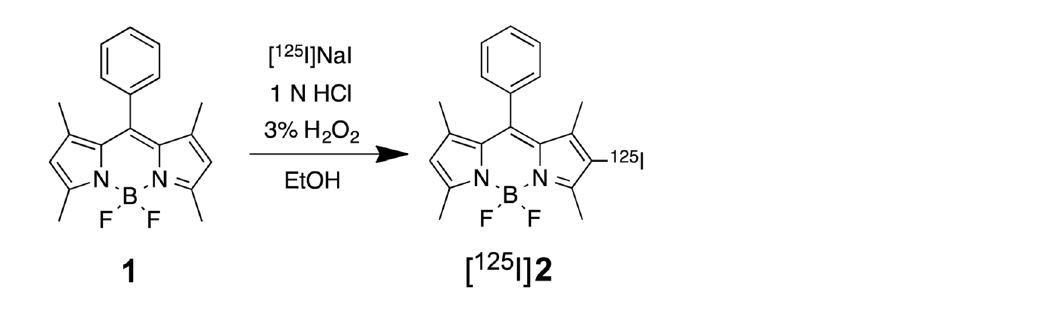
Figure 1. Chemical structures of BODIPY, [ 18 F]BODIPY, and [ 18 F]BODIPY ® FL-RGD.